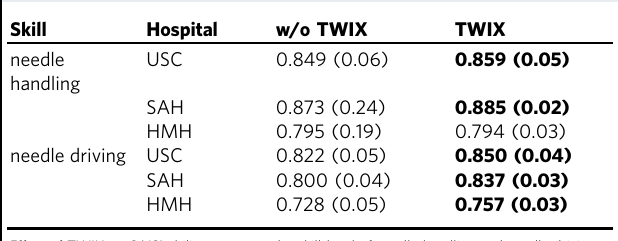
Table 2 TWIX often improves AI-based skill assessments across